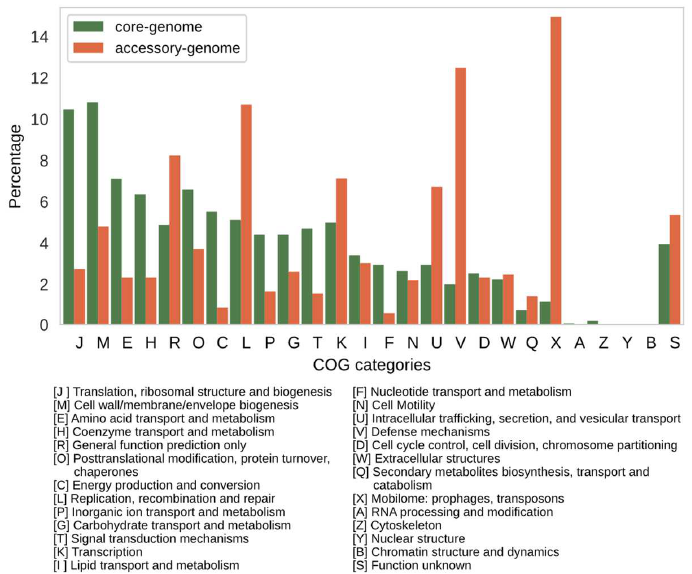
Figure 3. Profile of Clusters of Orthologous Groups (COG) functional categories in the core and accessory genomes of the 94 assemblies of X. fastidiosa strains. Distribution (percentage) of COG categories in the core (green bars) and accessory (orange bars)